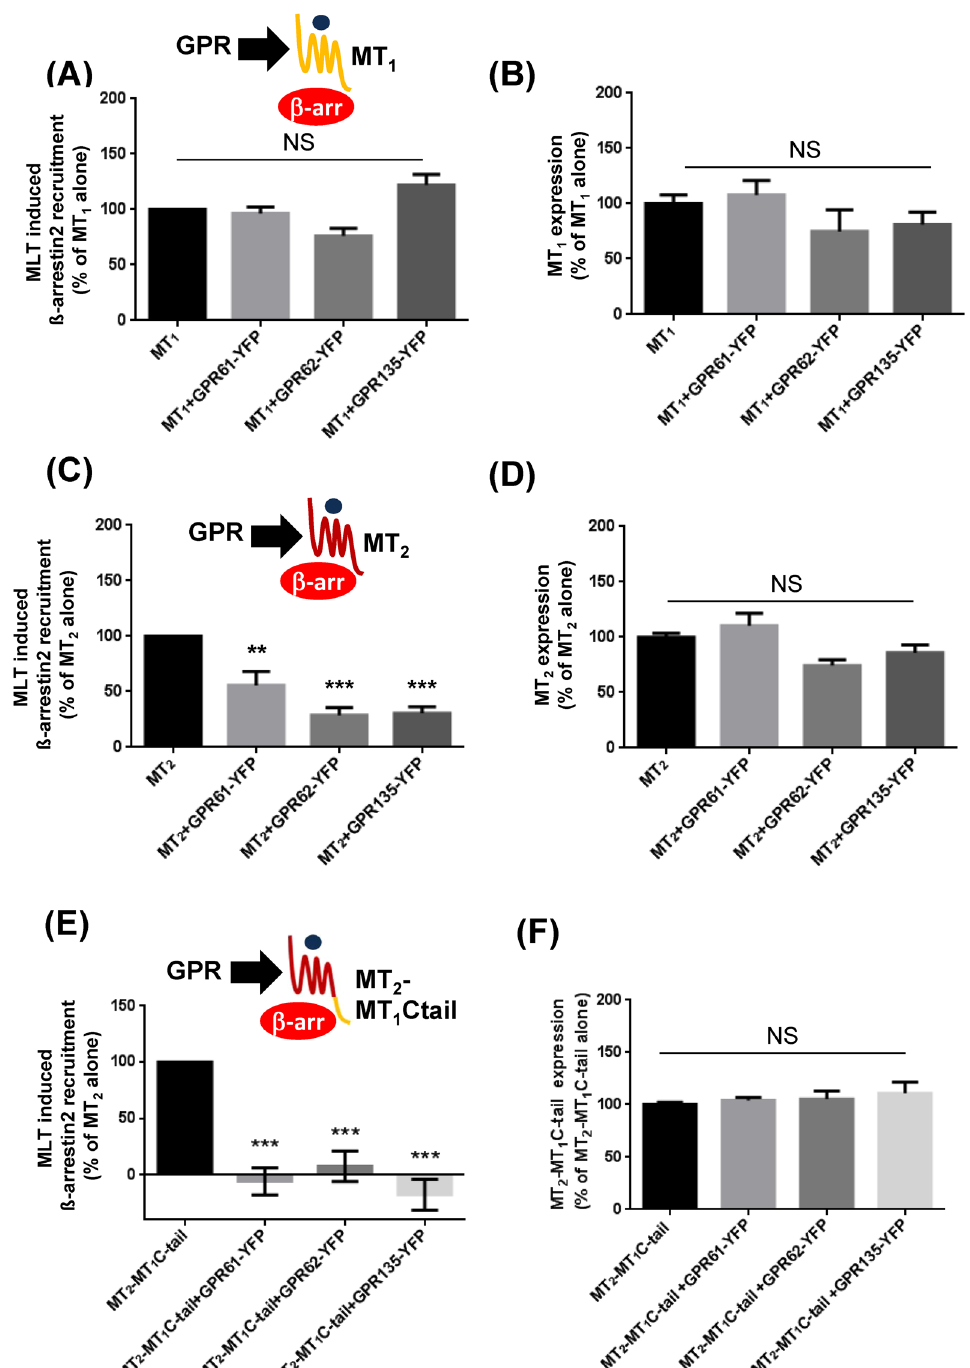
Figure 5. Effect of GPR61, GPR62 and GPR135 expression on melatonin-induced β -arrestin2 recruitment to MT 1 and MT 2 . ( A , C , E ) ß-arrestin recruitment was determined in HEK-arrestin-EA cells expressing the ß-arrestin2-EA fusion protein and the indicated receptors upon treatment with melatonin (1 µ M). Results are expressed as % of melatonin response obtained in cells expressing Flag-MT 1 -PK2 ( A ), HA-MT 2 -PK2 ( C ) or myc-MT 2 -MT 1 -Ctail-PK2 ( E ) alone. Expression levels of Flag-MT 1 -PK2 ( B ), HA-MT 2 -PK2 ( D ) and chimera myc-MT 2 -MT 1 -Ctail-PK2 ( F ) were monitored by ELISA assay. Data are expressed as mean ± SEM from at least 3 independent experiments. ** P < 0.01, *** P <